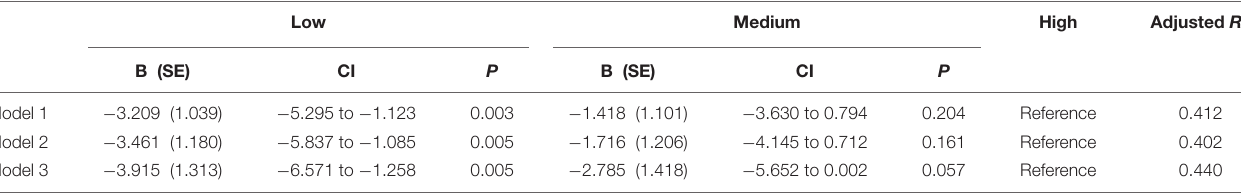
TABLE 5 | The results of multiple linear regression analyses assessing the associations between the serum copper strata and MMSE in MCI older adults.